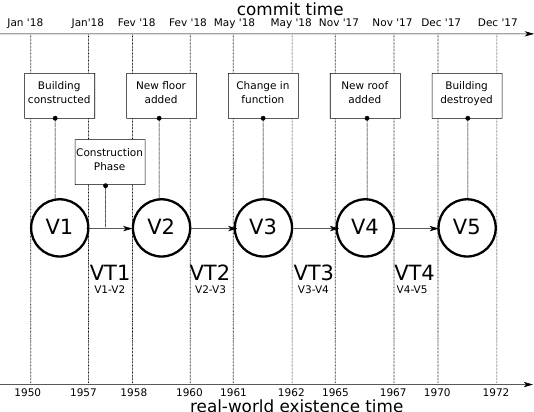
Figure 6. GIT commit time UrbanCo2Fab real-world existence time for versions and version transitions